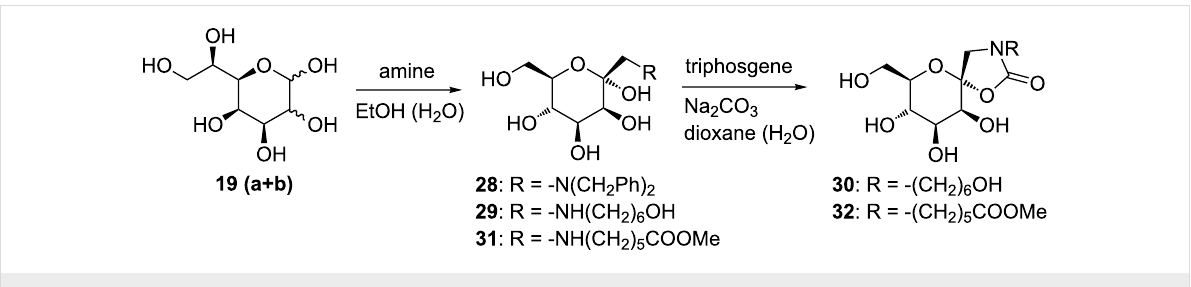
Scheme 6: Amadori rearrangement in the D- manno